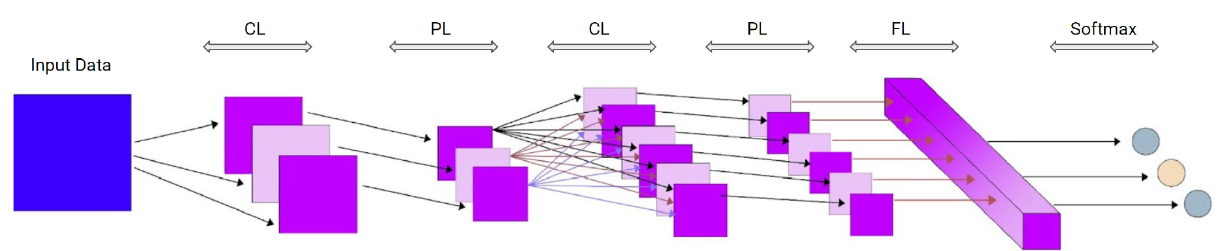
Figure 4. A CNN architecture consisting of two pairs of alternating convolution and pooling layers followed by a fully connected layer and a softmax layer